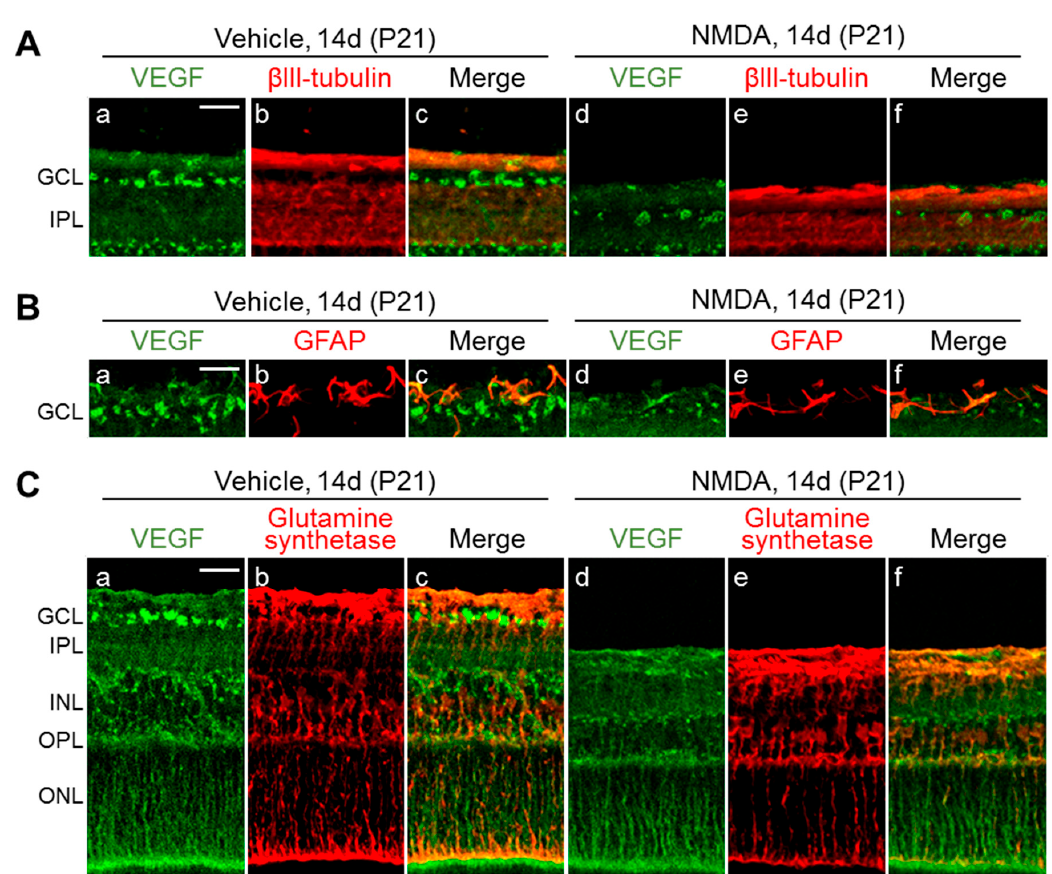
Figure 7. Colocalization of VEGF and cell type-specific markers in retinas of rats intravitreally injected with vehicle or NMDA. Cryosections stained with anti-VEGF antibody (green) plus one of the indicated cell-specific antibodies (red) obtained 14 days (P21) following intravitreal injection of vehicle or NMDA. ( A ) β III-tubulin; ( B ) GFAP; ( C ) Glutamine synthetase. Scale bar = 150 μ m in a (applies to